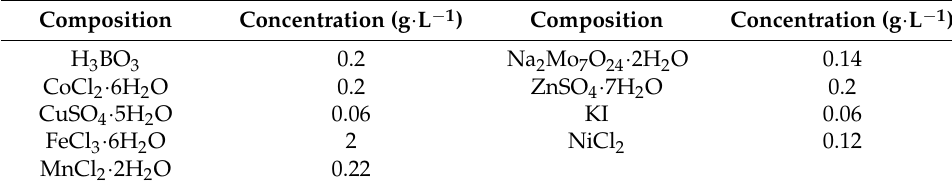
Table 2. Concentration of trace elements in the